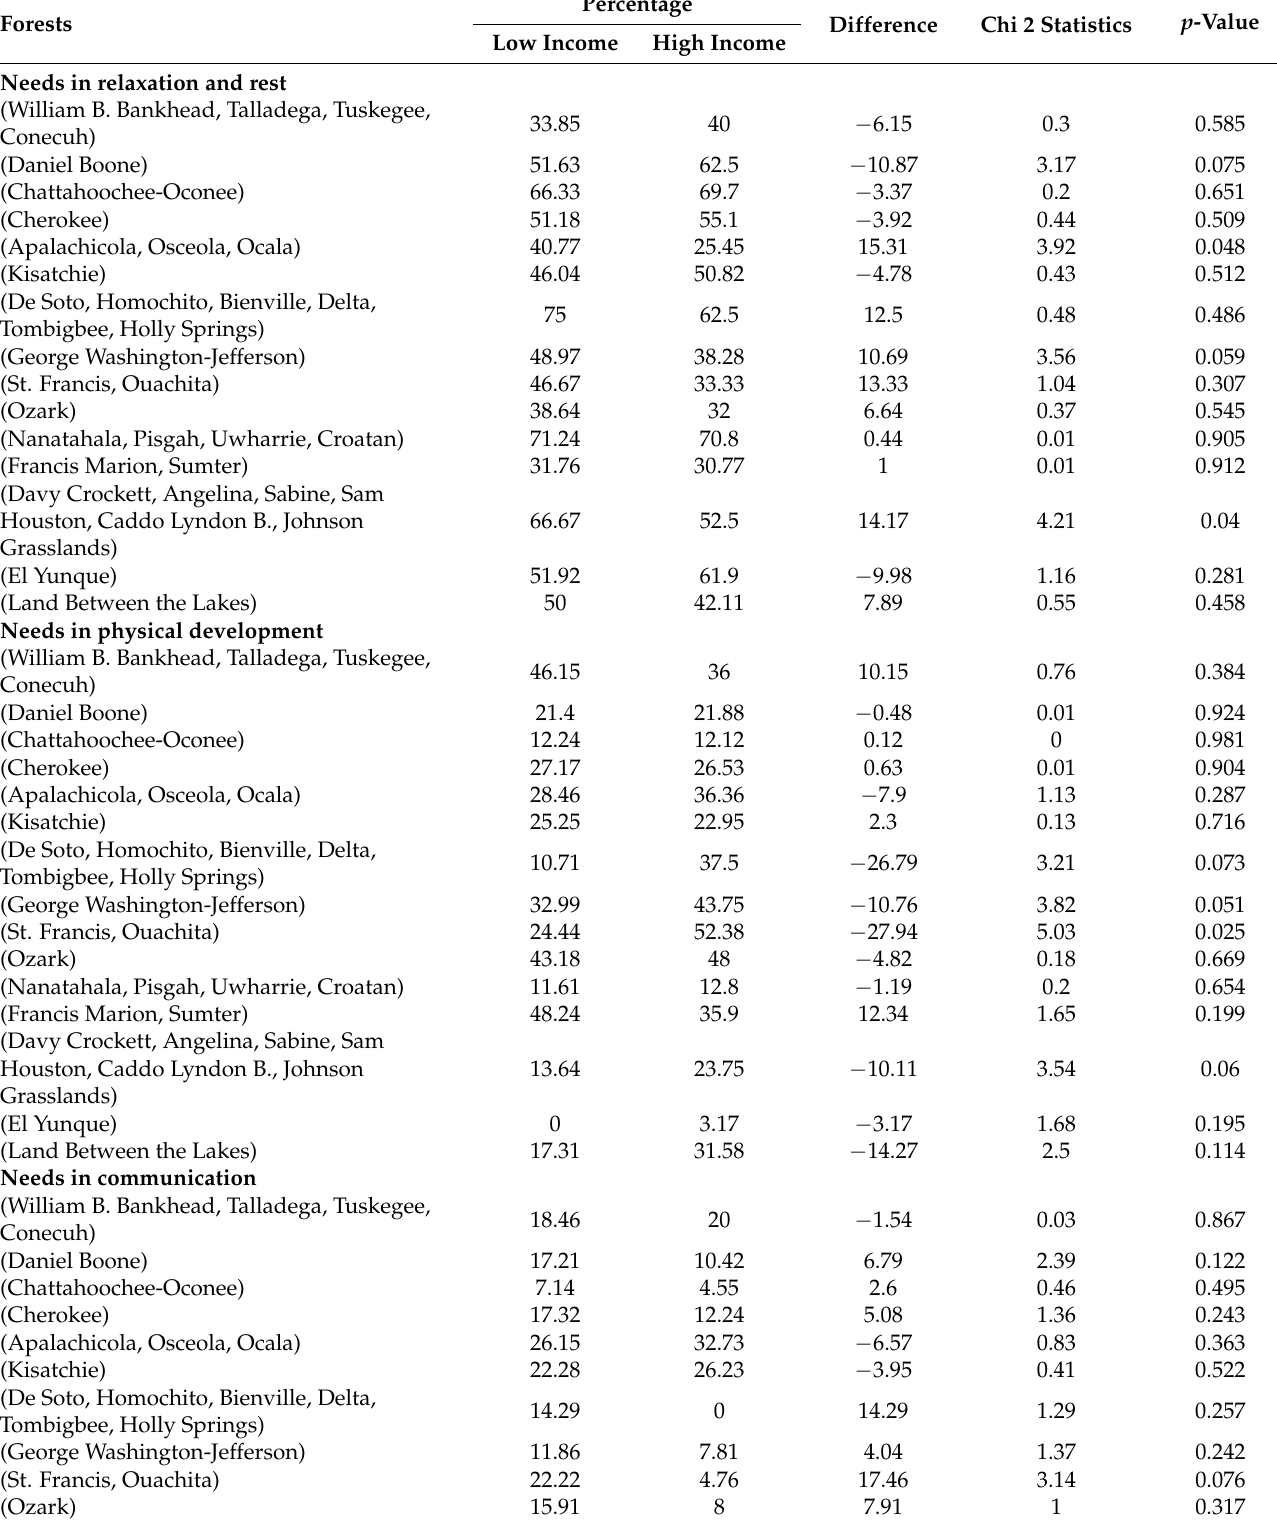
Table 7. The results of the Chi-square test for between-group (income) comparisons across forests. Percentage Forests Difference Chi 2 Statistics High